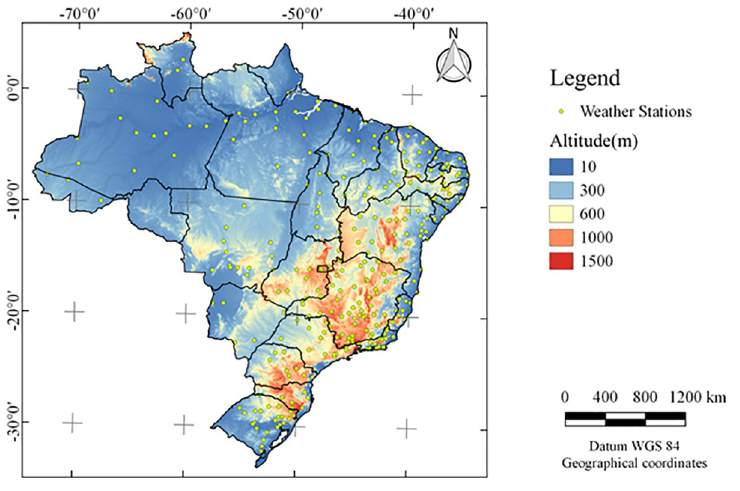
Fig 1. Location of Meteorological Database for Teaching and Research stations of